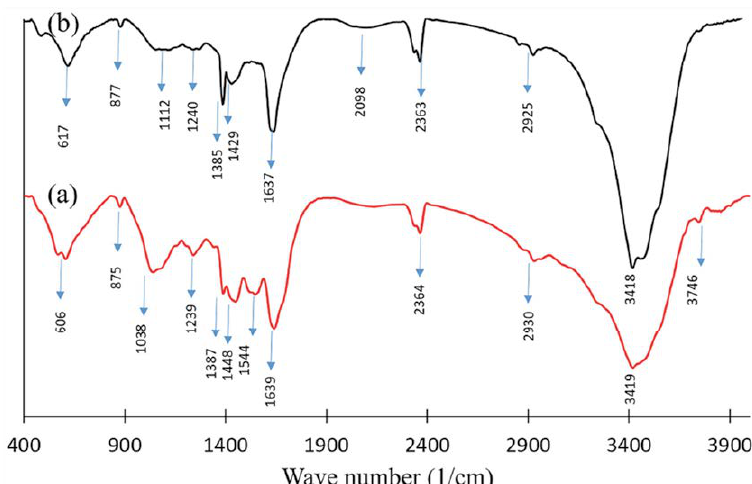
Fig. 2. FTIR spectra of the adsorbent (a) before (MFS) and (b) after (UMFS) adsorption of MB.